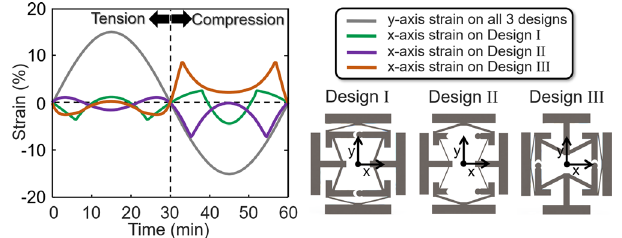
Fig. 4 The x -axis strain response of three different cell designs (i.e., Design I, II, and III) made of Te fl on to a sinusoidal y -axis strain load with an amplitude of